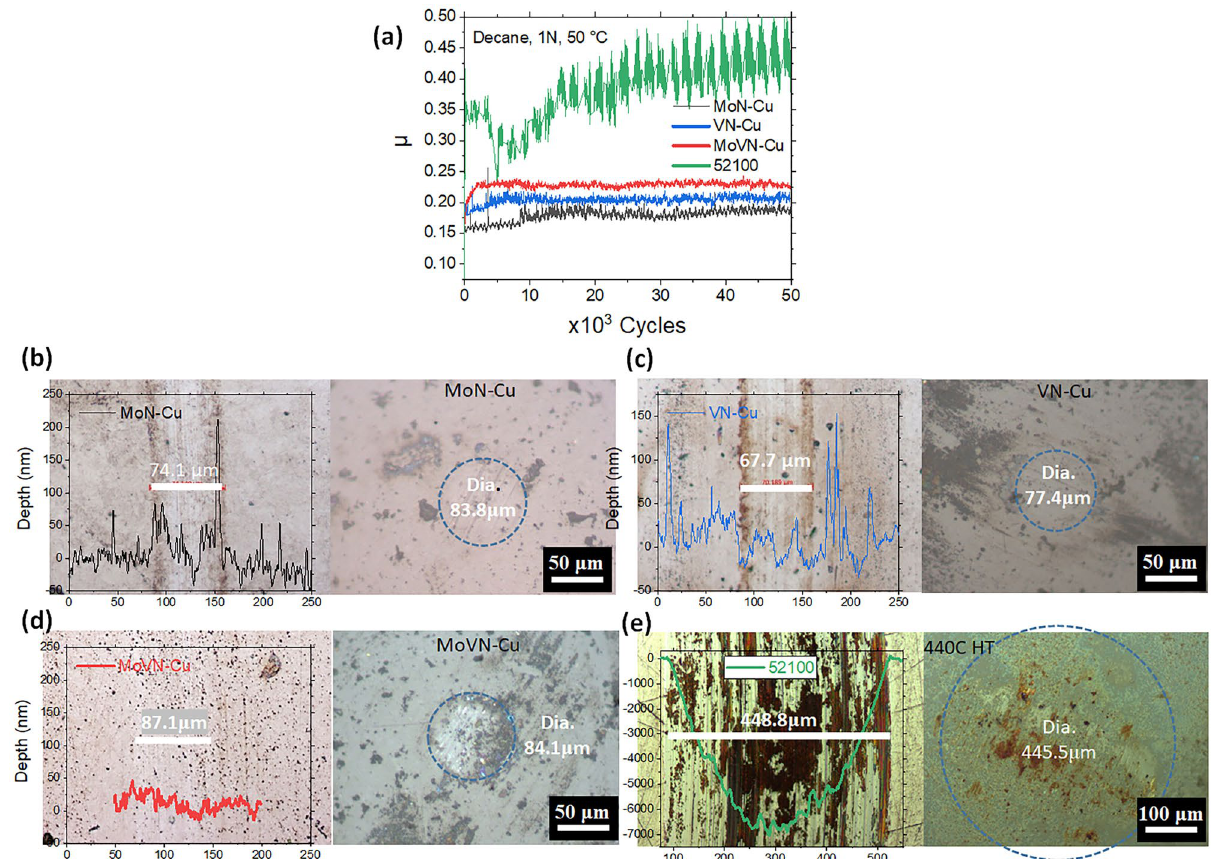
Figure 2. ( a ) Coefficient of friction values for films tested in decane at 1 N load and 50 °C. Optical micrographs of the contact areas and inserted stylus profilometry results of the wear tracks formed on ( b ) MoN-Cu, (c) VN-Cu, (d) MoVN-Cu films, and (e) 52100 steel substrate used as the reference